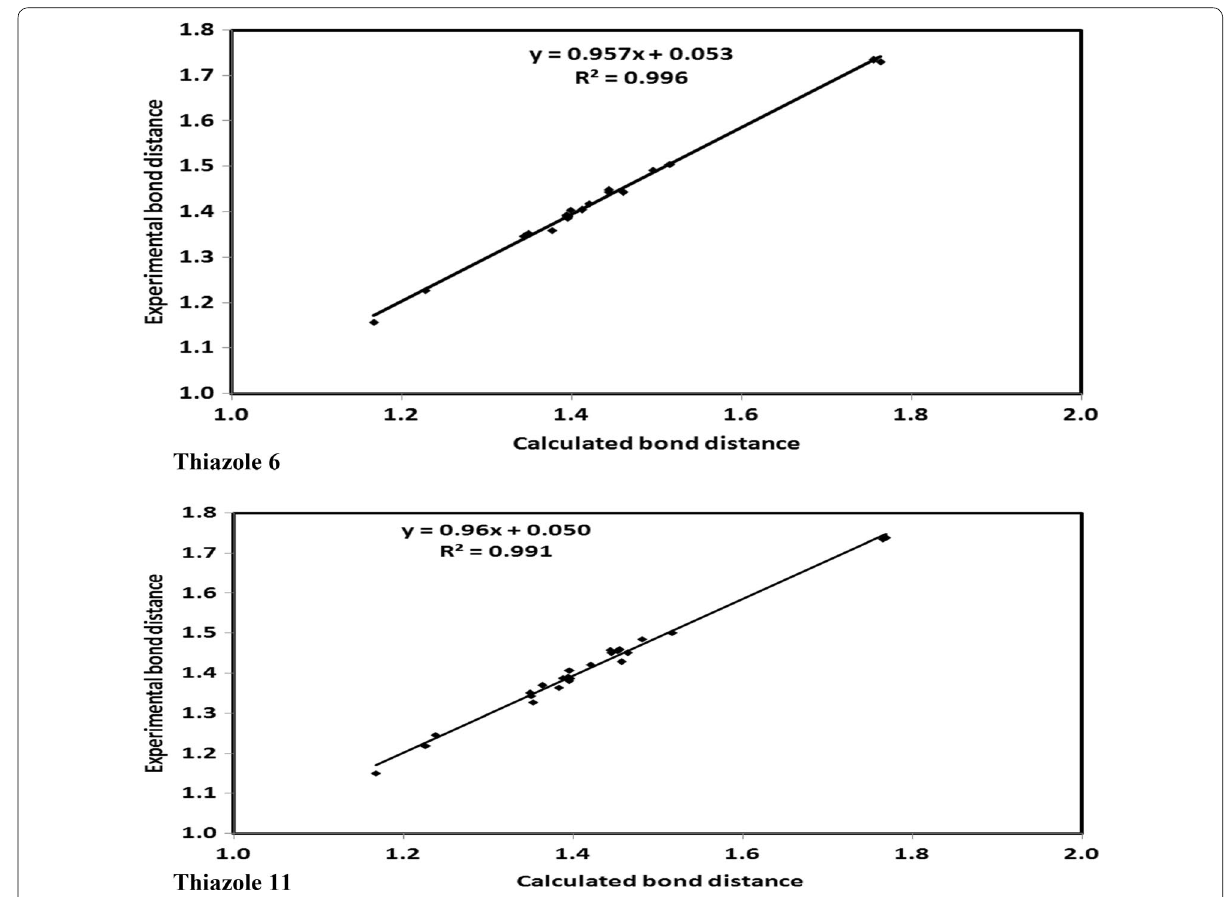
Fig. 6 The correlations between the calculated and experimental bond distances of the thiazoles 6 and 11